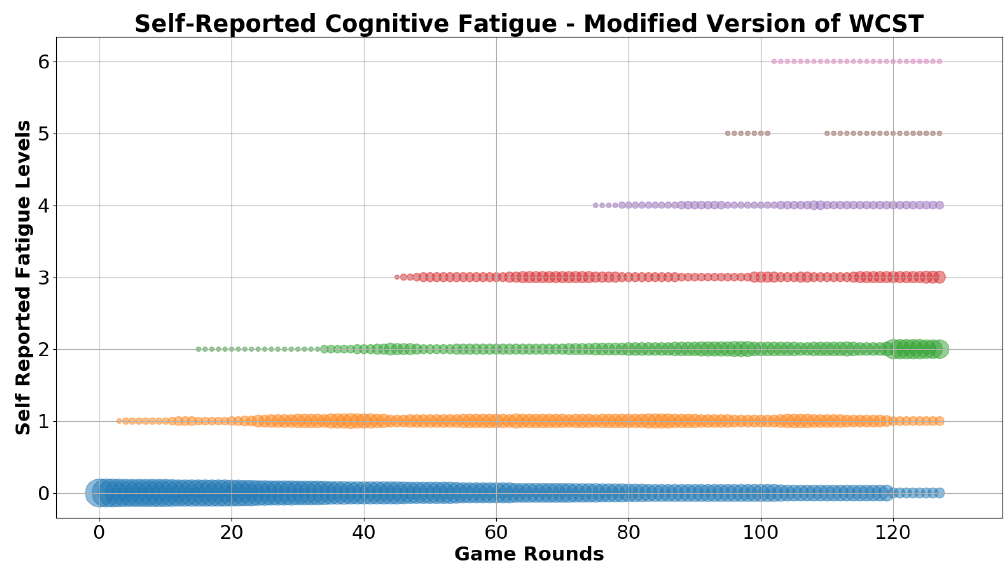
Figure 7. Self-reported levels of cognitive fatigue during the game. The thicker and denser the line is, the larger the group of users that it represents.